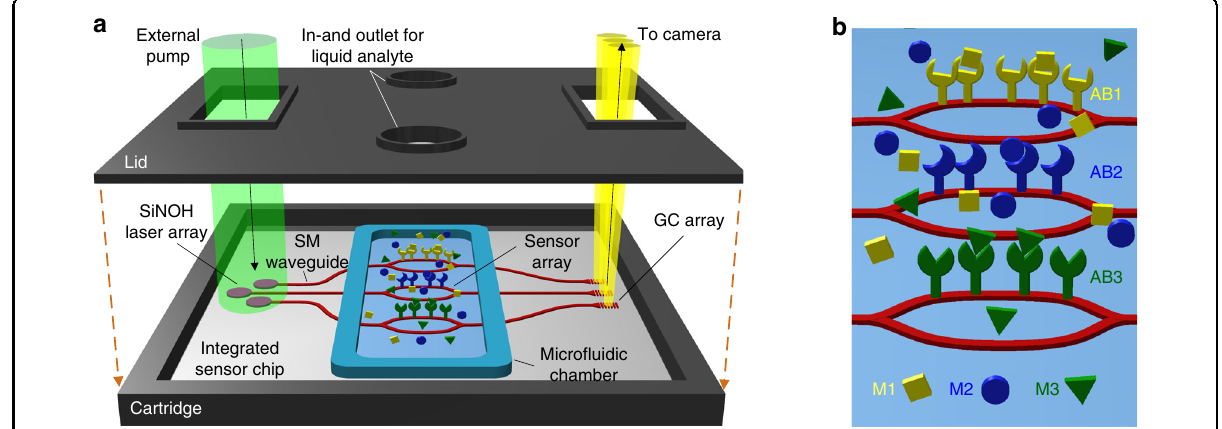
Fig. 1 Concept of the Si 3 N 4 -based biosensor with co-integrated lasers. a The Si 3 N 4 chip combines a SiNOH laser array with an array of sensors, illustrated as Mach-Zehnder interferometers (MZI), and is placed in a cartridge (black) containing windows for optical pumping and read-out. The sensor comprises a micro fl uidic chamber with an in- and outlet for the liquid analyte solution, which is formed by the chip surface, the cartridge lid, and an elastic seal (blue) between the chip surface and lid acting as the chamber sidewalls. The integrated SiNOH lasers are pumped by an external light source with a large pump spot size such that high-precision alignment is not needed. The light originating from the sensor output is radiated from the chip to a read-out camera by grating couplers. b Simpli fi ed schematic of the MZI-based sensor. Each MZI contains one sensing and one reference arm. The sensing arms are functionalized with individual antibodies AB1, AB2, and AB3 that bind speci fi c target molecules M1, M2, and M3, respectively, to the WG